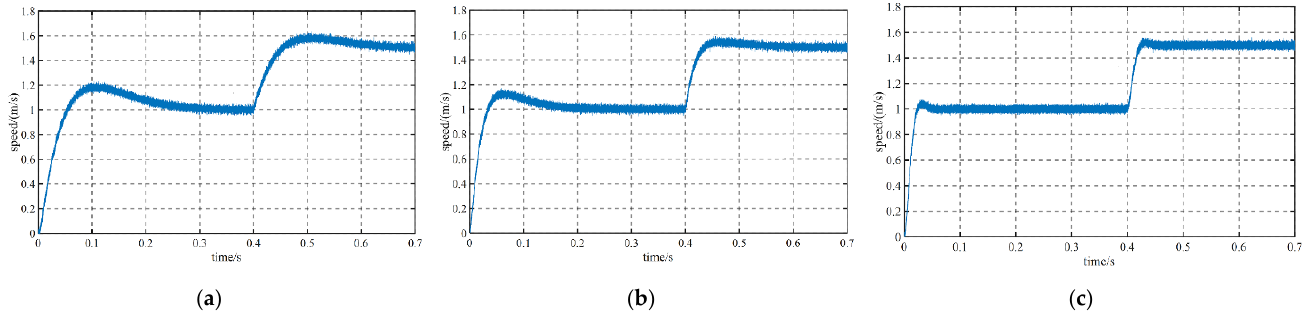
Figure 14. Comparison of the tracking performance of the three systems: ( a ) PI system; ( b ) SMC system; and ( c ) MPC system.